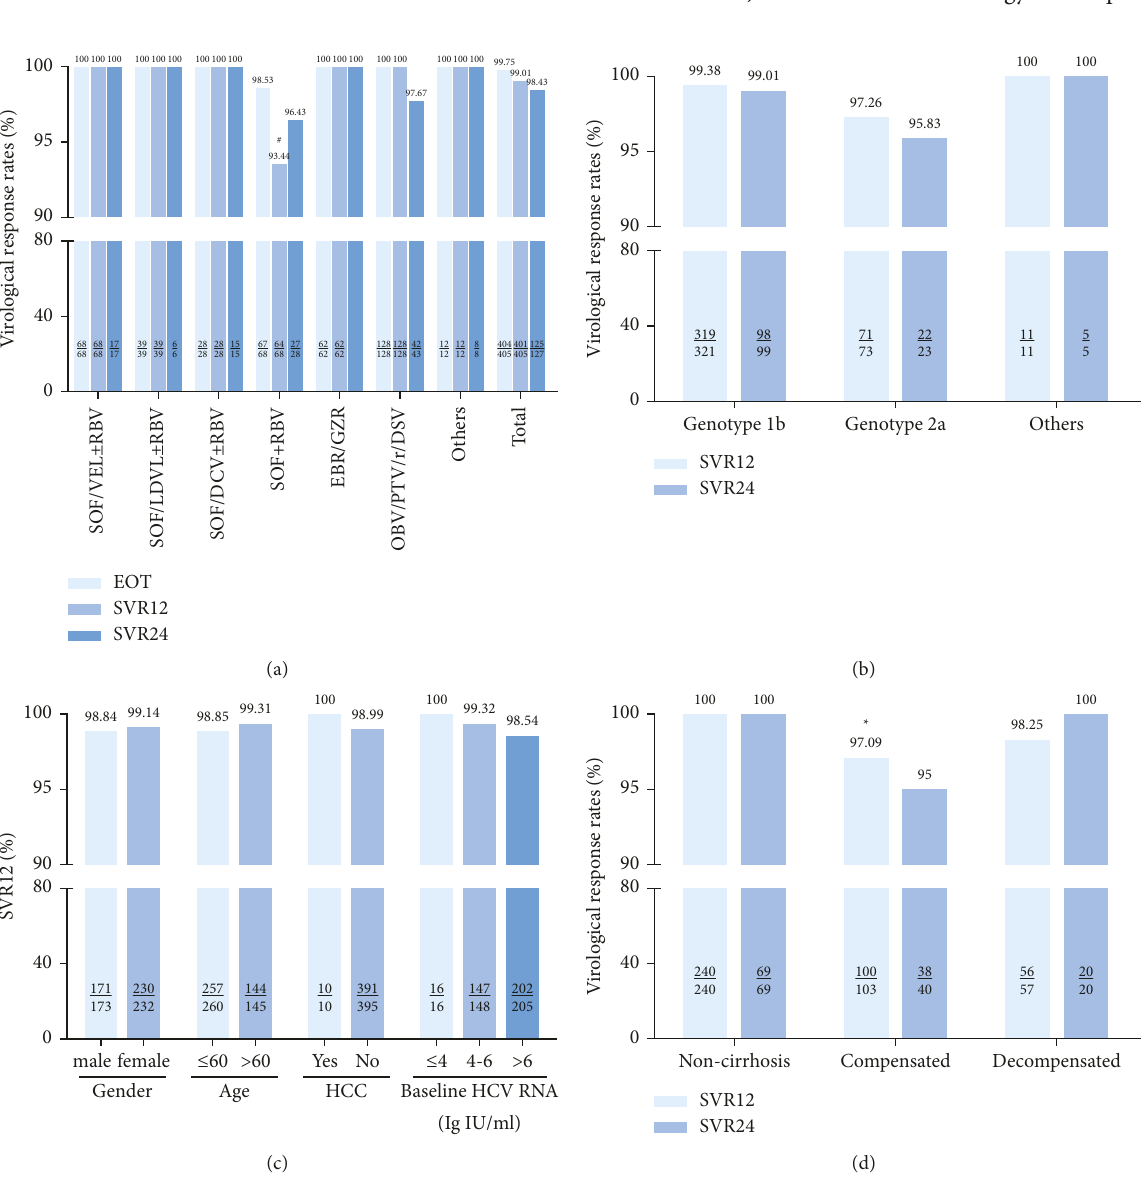
0 . 011, and SVR12 in (cid:31)